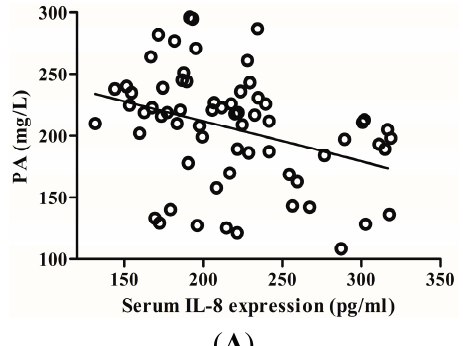
Figure 5. The correlation between prealbumin (PA) levels and IL-8 expression. ( A ) Serum IL-8 protein was negatively correlated with serum PA; ( B ) PBMCs IL-8 mRNA was also negatively correlated with serum PA